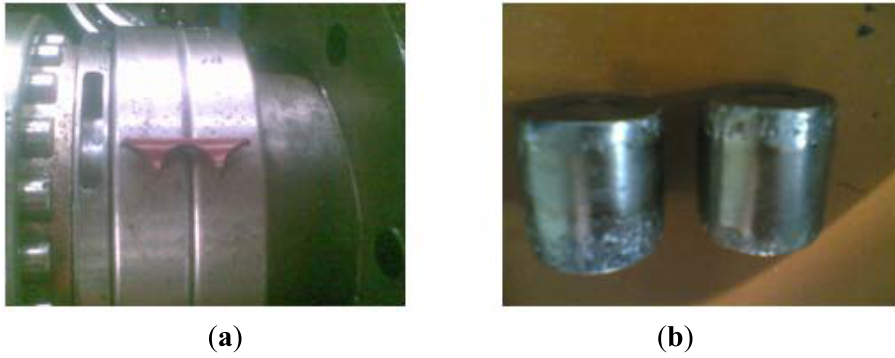
Figure 10. Schematic diagram of the damaged bearing on axle I at the north output end of the speed increasing box: ( a ) bearing with a rolling element fault; ( b ) rolling element with pitting